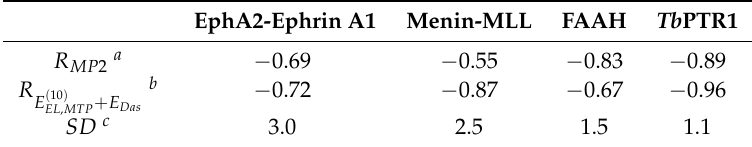
( 10 ) + E Das models and differences in ligand solvation free EL , MTP